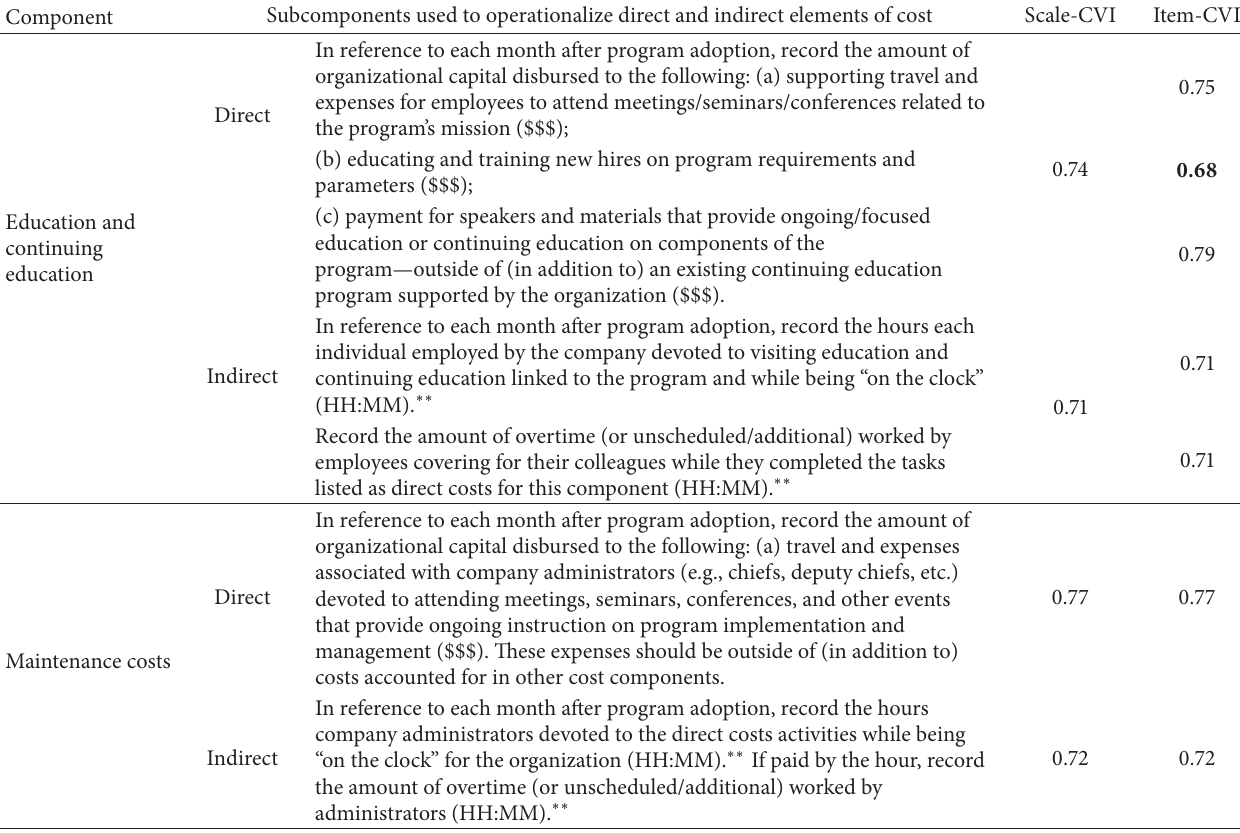
Table notes: Components and subcomponents colored in bold font fail to meet the 0.70 cut-point/benchmark for content validity in this study and thus should be removed from the final algorithm, which is presented in Table 2. ∗∗ Thealgorithmwillrequiremultiplyinghours(time)bythehourlyrateperperson.Applythehourlywageforemployeespaidperhour.Forsalariedpersonnel, divide the salary by a standard work year (50 weeks) and workweek (37–40 hours) to determine hourly wage for cost